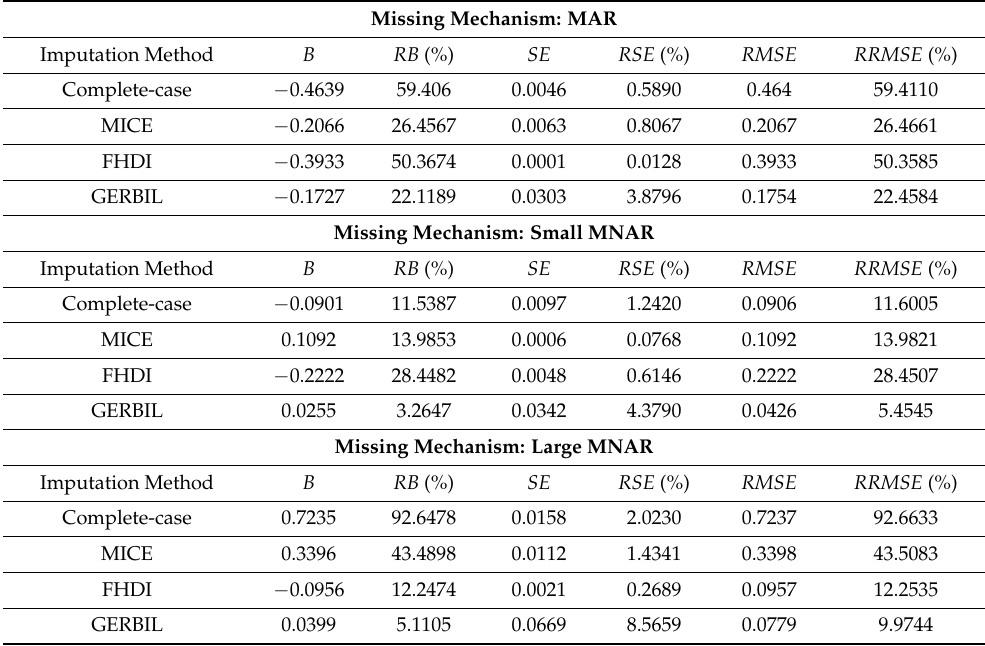
Table 5. Summary of Simulation Results for Regression Coefficient for BRFSS Variable “Whether Diabetes has Affected